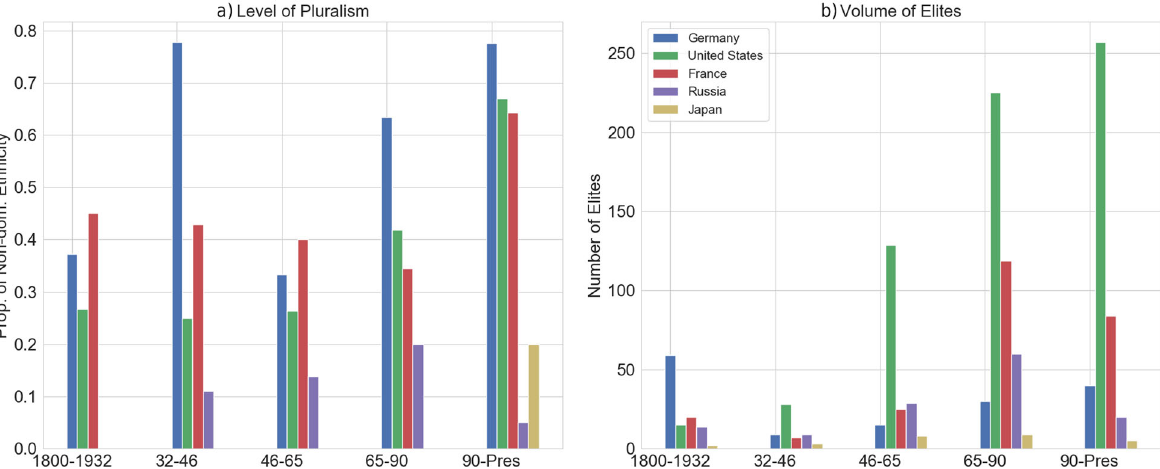
Fig. 2 Upper-bounds of pluralism. Pluralism measure is de fi ned by the proportion of elite mathematicians that are not part of the majority lingo-ethnic identity. a The proportion of elite minority groups within a time period. b The number of elite mathematicians in each country.